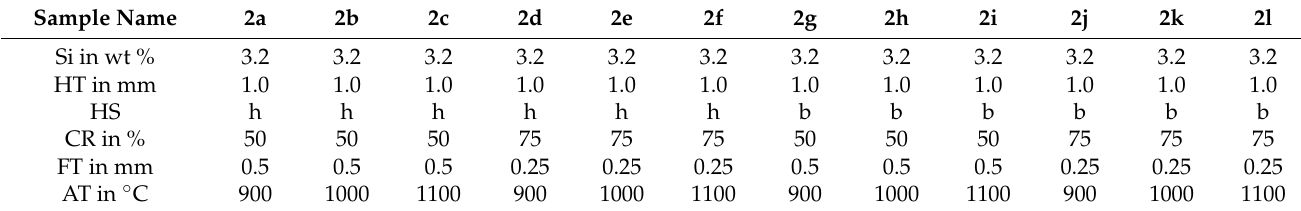
Table 2. Overview and sample names of the processing routes for the Fe–3.2 wt % Si.